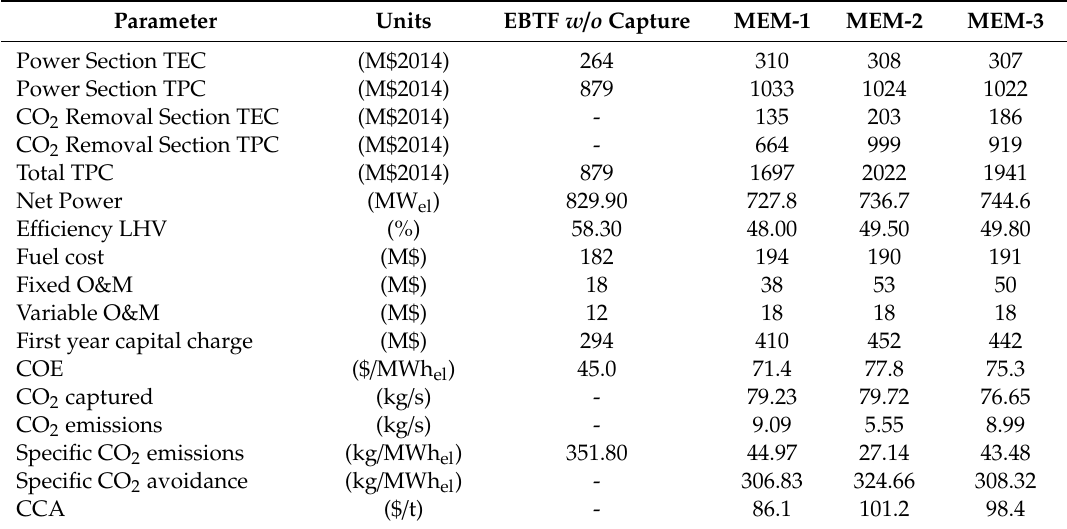
Table 12. Membrane economic evaluation of membrane-based schemes.